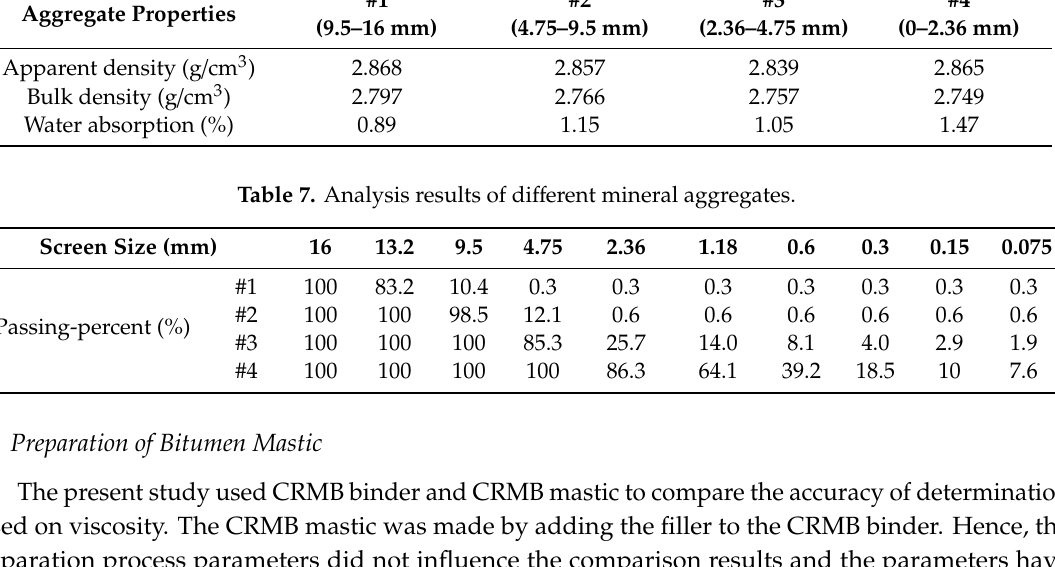
Table 6. Test results of the aggregates’ properties.